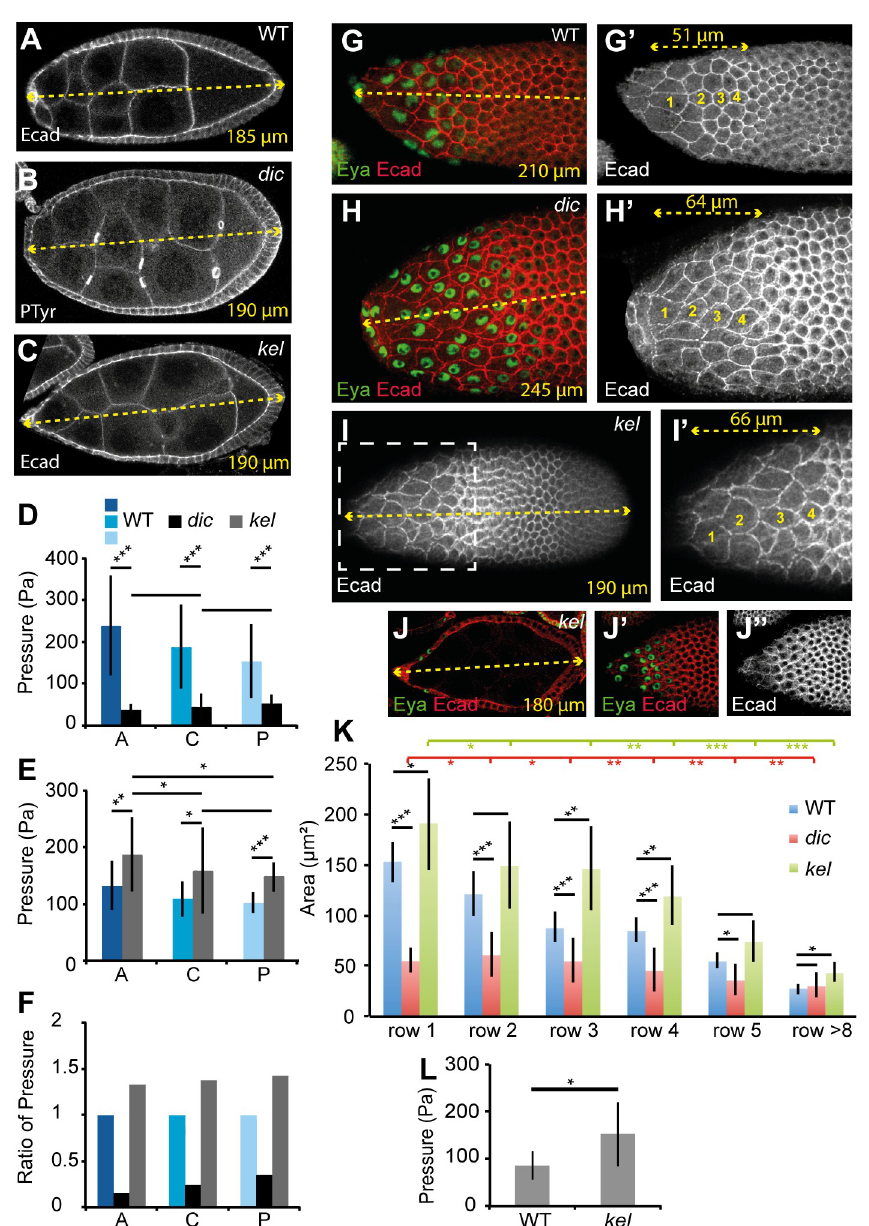
Fig 3. The gradient of NC pressure controls the timing and the wave of StC flattening. (A-C) Cross-section of WT (A; S8), dic (B; S8), or kel (C; ES9) follicles showing NC membrane curvature. The length of the follicle is indicated in yellow. (D) Inner pressure of S10 anterior (“A”), central (“C”), or posterior (“P”) NC between dic and WT ( n > 12 for WT, n = 5 for dic ). (E) Inner pressure of anterior, central, or posterior NC between kel and WT S10 follicles ( n > 10 for WT, n > 7 for kel ). Note that WT values in (D) and (E) are specific to each experiment (see Materials and methods). (F) Ratio of pressure in S10 anterior, central, or posterior NC between dic , kel , and WT. (G-H) StC flattening in mid S9 WT (G) or dic (H) follicles. Note that most of the anterior dic cells have a similar apical area that the anterior WT cells of row 1 and 2, but for a much longer follicle length (the dashed yellow line corresponds either to the follicle length or to the length of the region of interest). (I, J) kel follicle displaying the progressive wave of flattening (I) and a premature StC flattening (J). Surface views (I, I’, J’, J”) of the follicle or view across the follicle (J); (I’) is a magnified view of the box drawn in (I). For (G-I), four cells are numbered in yellow along the A/P axis. Eya is used to visualize StC nuclei. For staging dic or kel follicles, see Materials and methods. (K) Apical StC surface area by position along the A/P axis in WT (blue), dic (red), or kel (green) mid S9 follicles ( n > 10 cells for each row). Statistical comparisons between WT and dic or WT and kel are indicated in black, between dic rows in red and between kel rows in green. (L) Inner pressure of WT and kel anterior NC in mid S9 follicles ( n = 12 for WT, n = 10 for kel ). Data for graphs (D), (E),